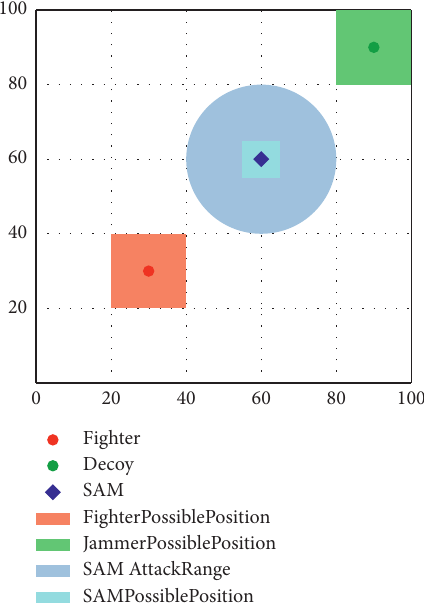
Figure 12: SEAD environment with different initial positions.